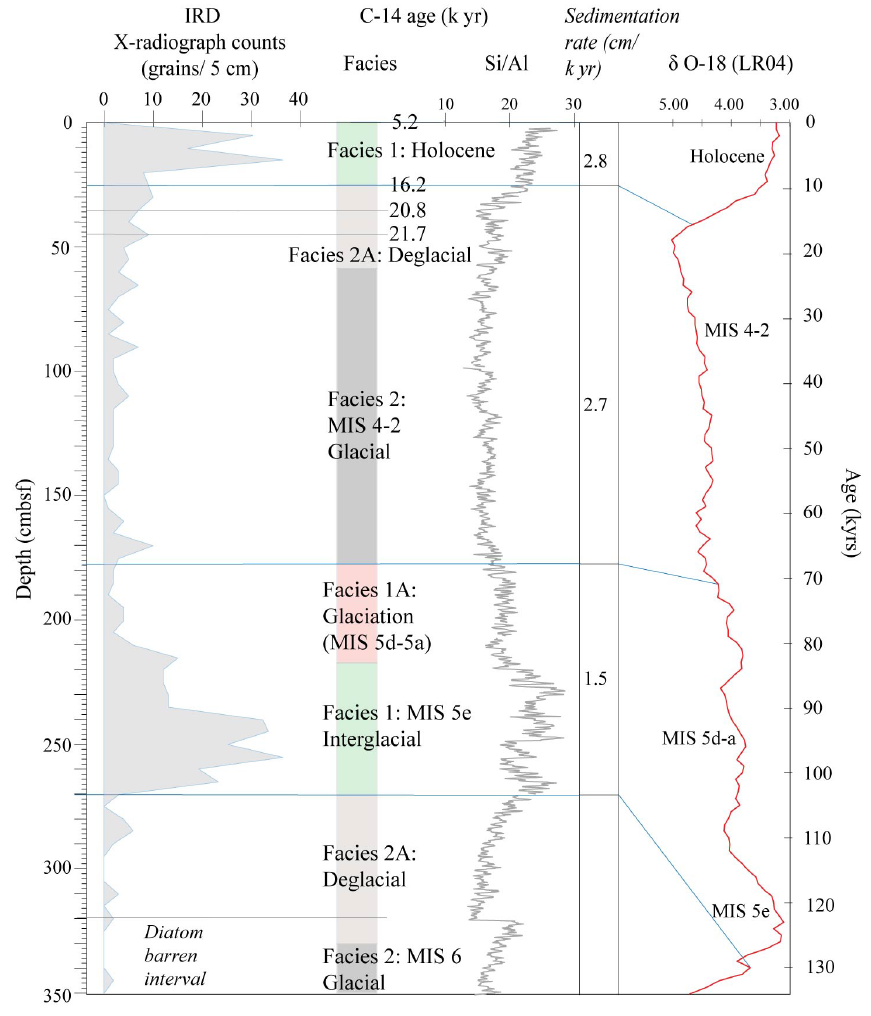
Figure 2. IRD counts, facies model and Si/Al for core Tan_44. The age model is based on the facies model and is supported by radiocarbon dating of two depths at the top of the core and the comparison of Si/Al to the global benthic stable isotope stack LR04 (Lisiecki and Raymo,